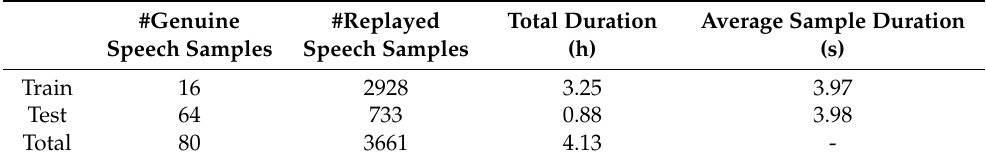
Table 1. The information of high sampling rate database.